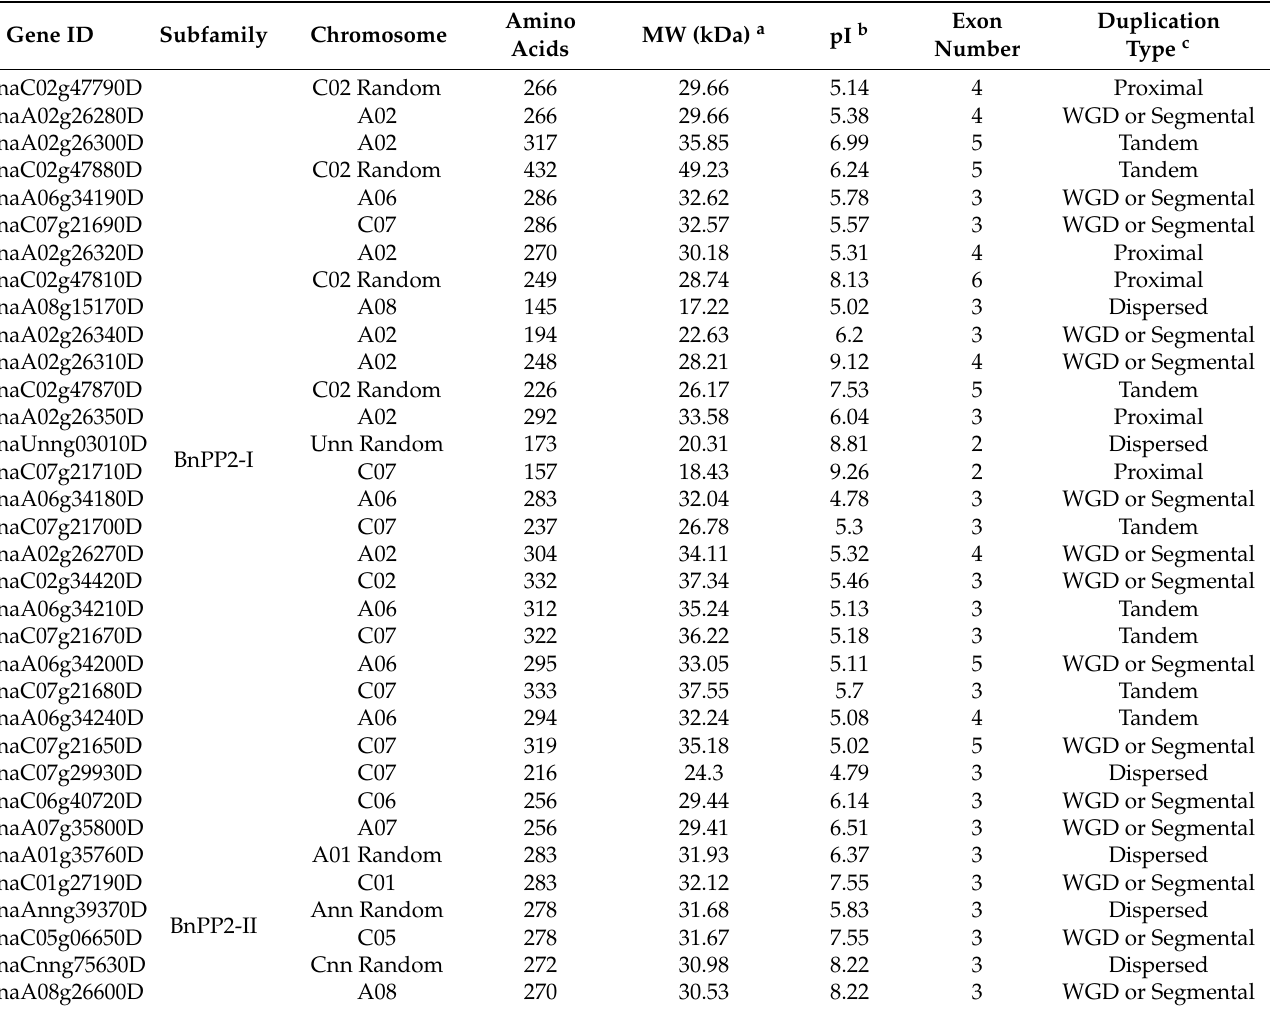
Table 1. A summary of the detailed characteristics of BnPP2s